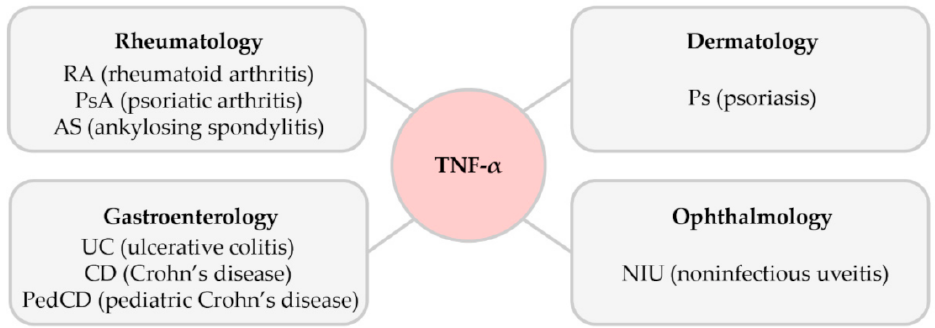
Figure 7. The association of TNF- α in various autoimmune